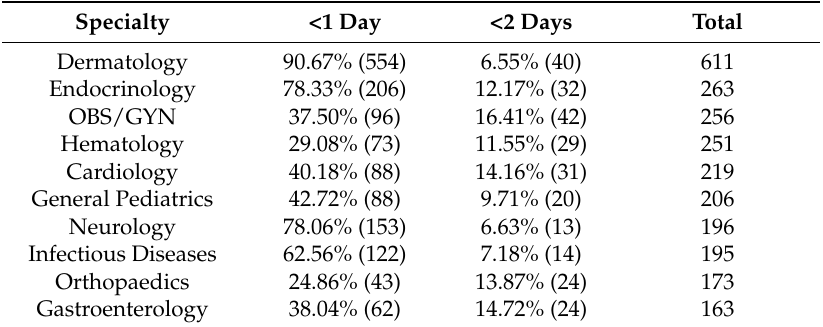
Table 3. Distribution of the time to complete eConsult for the ten most popular